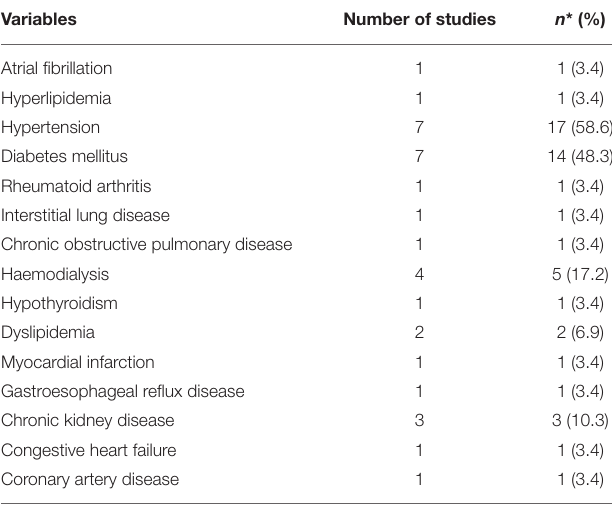
TABLE 4 | Comorbidities in coinfected patients in case reports/case series studies among a total of 29 evaluated patients.